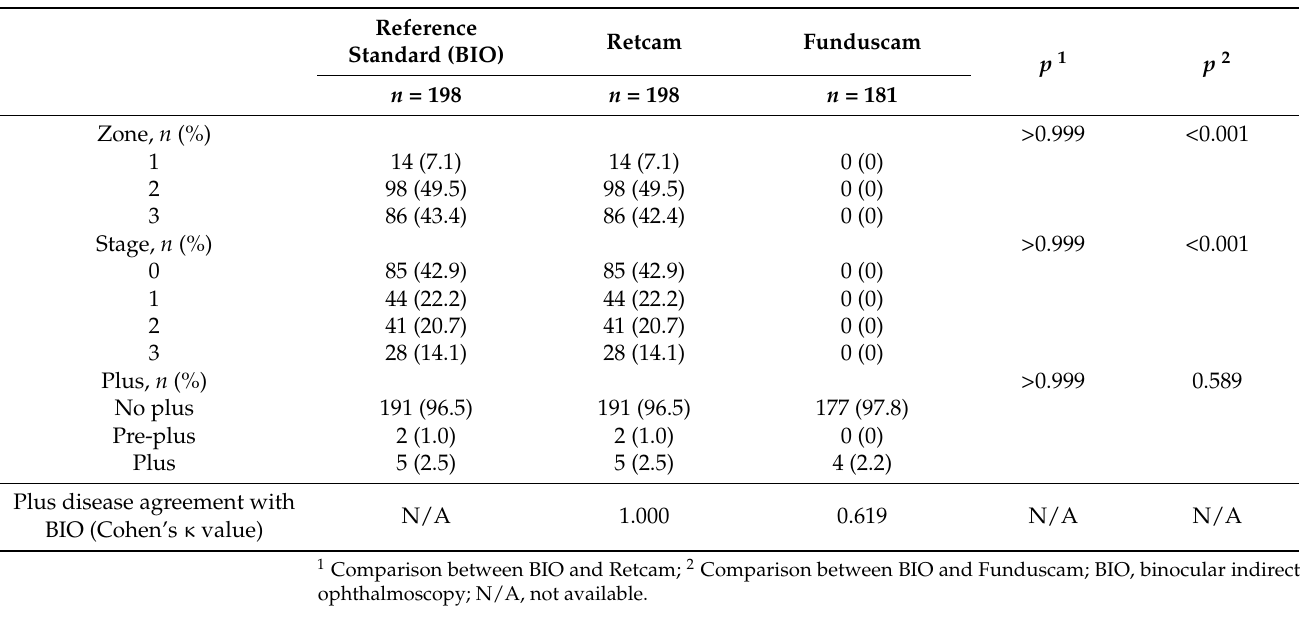
Table 3. Agreement of image devices with clinical examination.